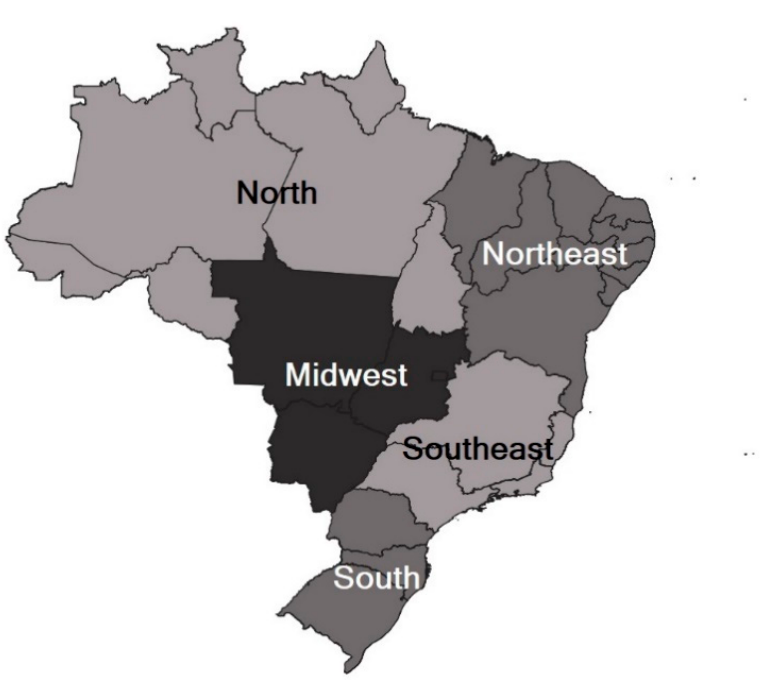
Figure 2. Brazilian geographic regions. The north region (NO) is the largest region in Brazil, occupying 45% of the national territory, 90% of which is covered by the Amazon Rainforest. There are two large cities